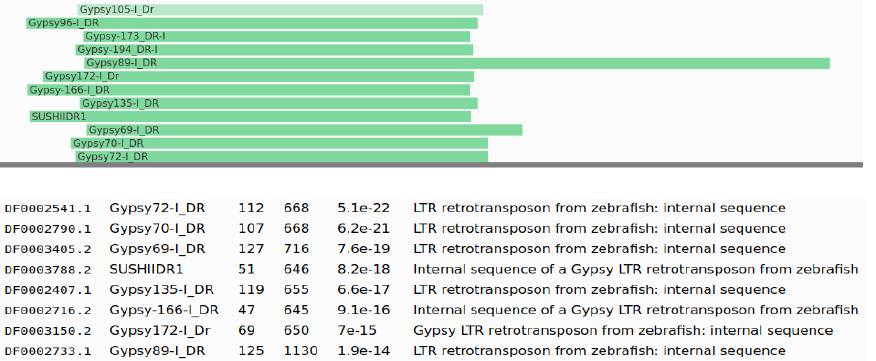
Figure 4. Plot of Dfam alignments from a TE model (internal name Csui_35) from Cystoisospora suis that has hits with Gypsy transposons from the Dfam database. The green lines represent the position and length of the hit, with the original sequence as the lower line in grey.